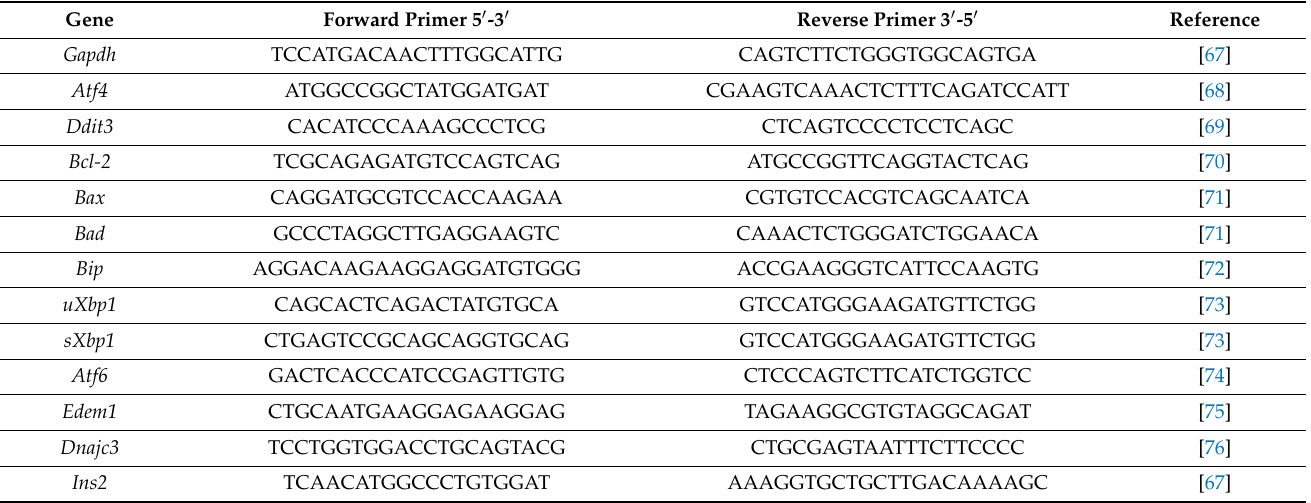
Table 1. Primers